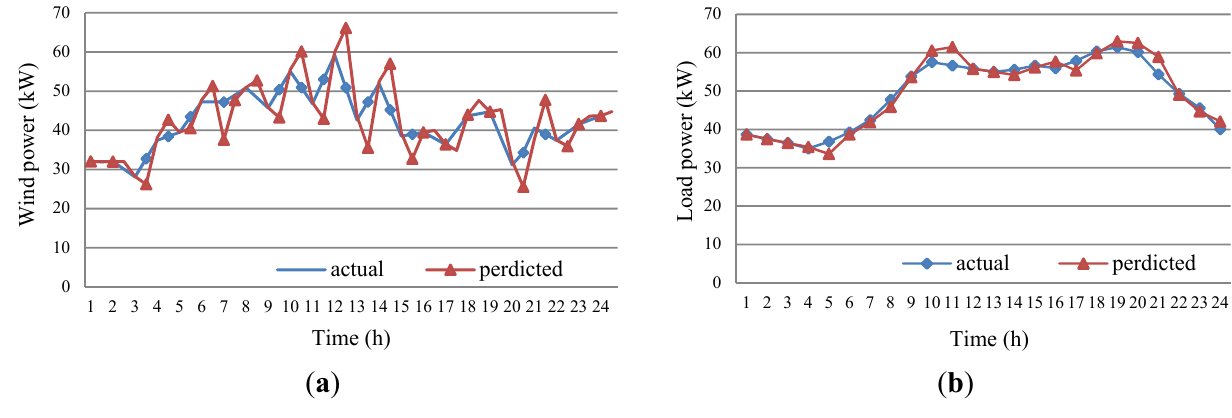
Figure 6. The predictive and actual wind and load power: ( a ) The predictive wind power curve within 24 h; ( b ) The predictive load power curve within 24